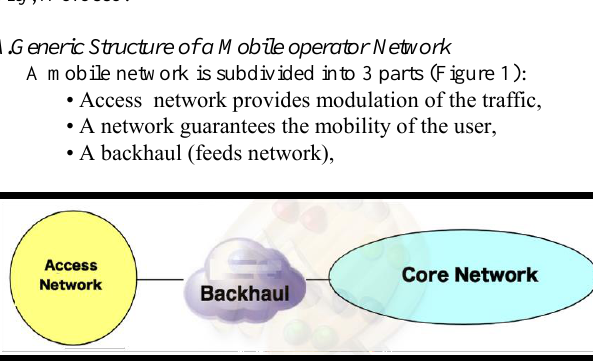
Figure 1. Three Parts of network The access network provides coverage of geographical areas called cells. These latter have a hexagonal shape. Their size can vary from thirty kilometres to a few meters depending on the intensity of the traffic, and the type of antenna used. In addition to this, the size of a cell is not fixed. In fact, it contracts or expands, depending on the weather, the presence of obstacles and the intensity of traffic. Each cell contains hardware and software needed to communicate with mobile stations (Zoha et al., 2018) These parts link the access network with the core network. The links of the supply network may be optical fiber, copper or supported by radio-relay